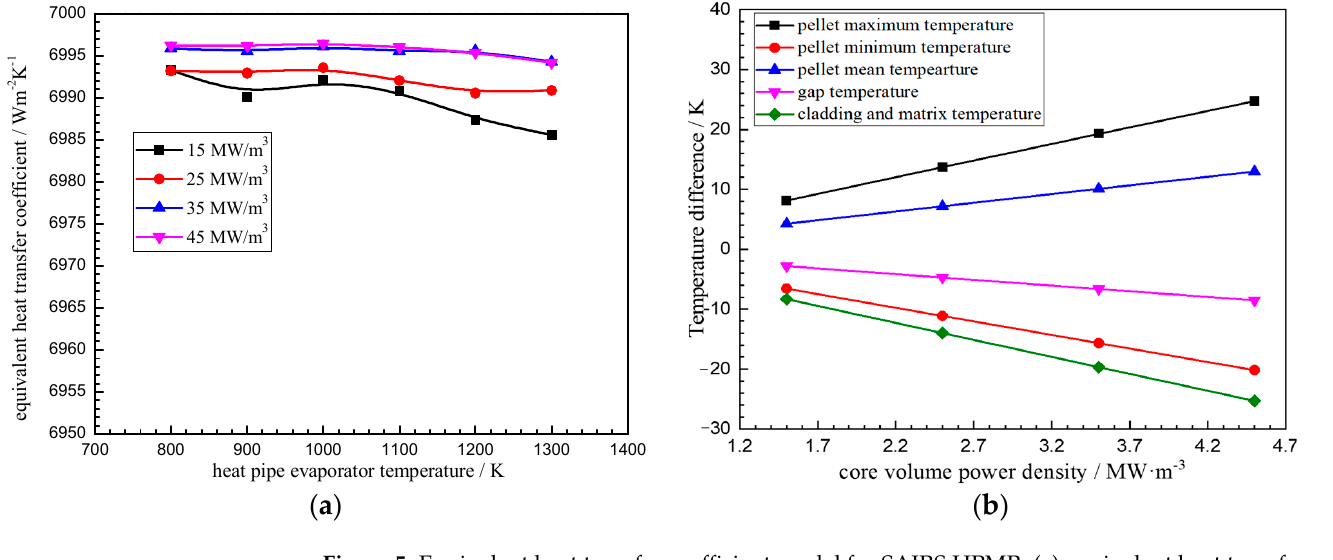
Figure 5. Equivalent heat transfer coefficient model for SAIRS HPMR: ( a ) equivalent heat transfer coefficient and ( b ) temperatures of different fuel materials.